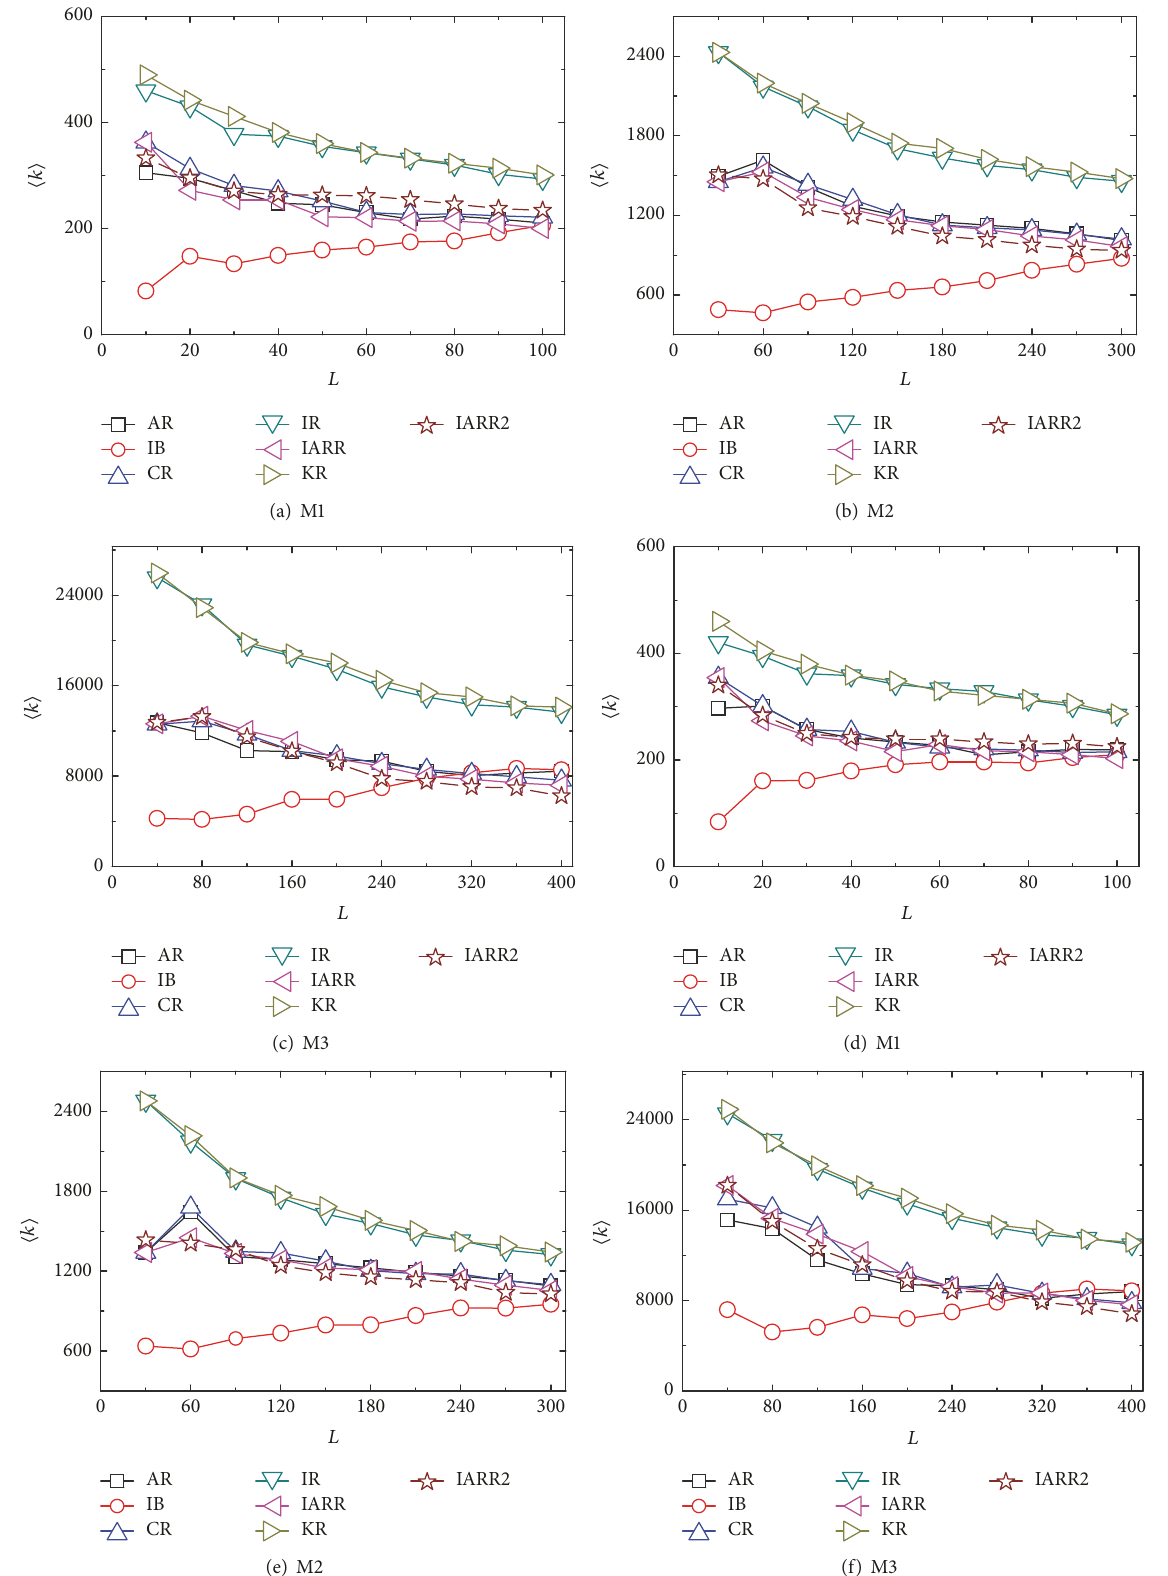
Figure 5: Algorithmic novelty of five methods on three MovieLens datasets. Due to the different sizes of the three datasets, we set the maximum 𝐿 equal to 100 , 300 , and 400 for M1, M2, and M3, respectively. (a)–(c) Results found by evaluation with the Academy Awards, (d)–(f) results by evaluation with the Golden Globe